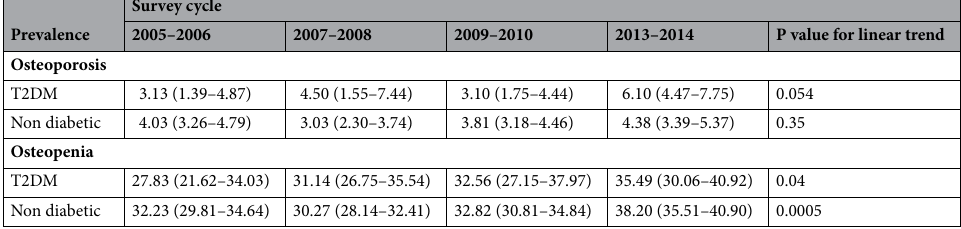
Table 2. Age- and BMI-adjusted prevalence of osteoporosis and osteopenia among T2DM patients and non- diabetic population in 4 NHANES (2005–2006, 2007–2008, 2009–2010, and 2013–2014).